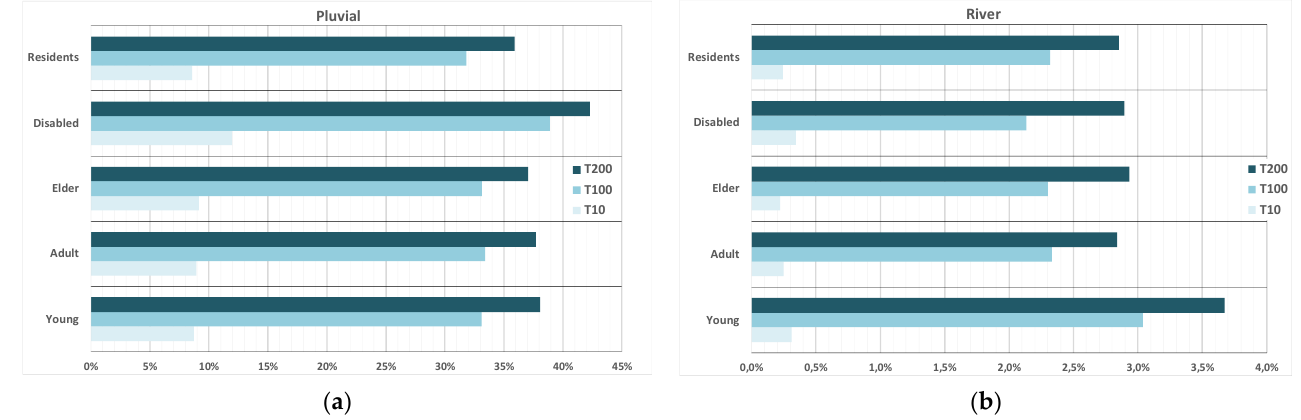
Figure 6. Social service accessibility impact: ( a ) pluvial flood; ( b ) river flood.